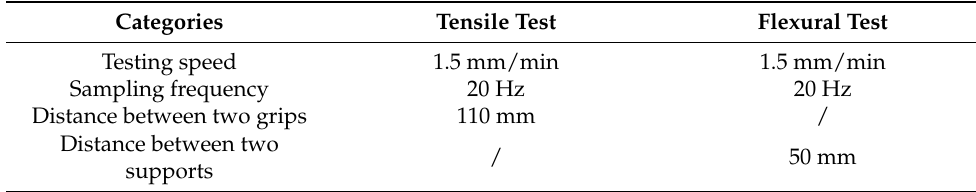
Table 2. Experimental parameters of the tensile and flexural